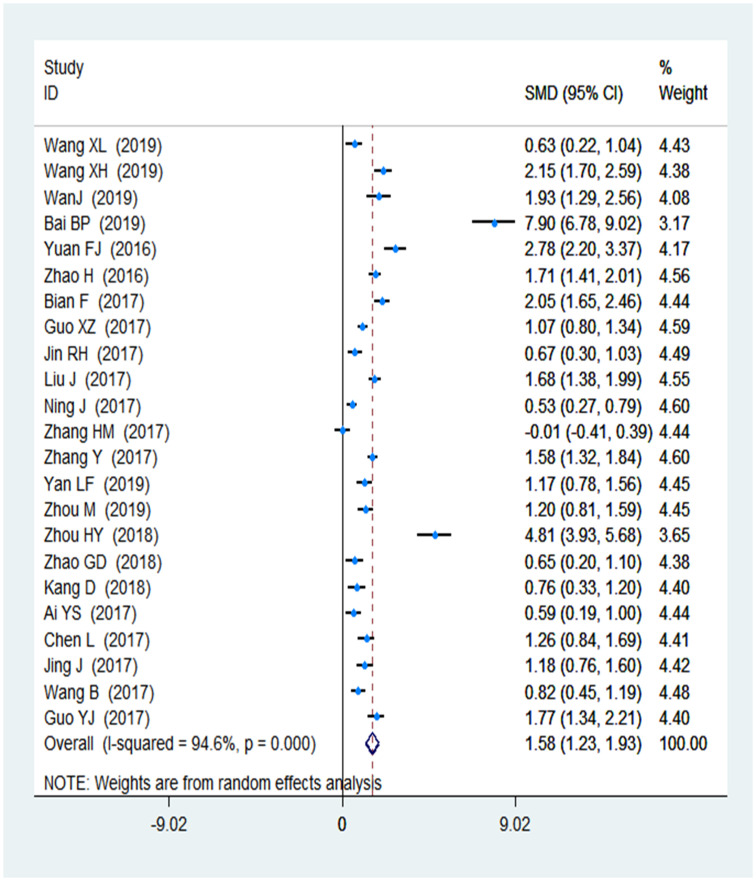
Forest plot of the nursing students' skills scores.